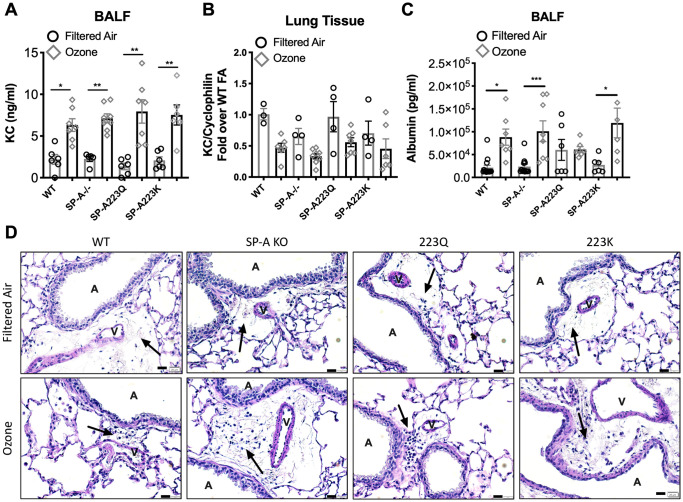
Genetic variation in SP-A2 on vascular permeability after exposure to ozone.(A) KC levels in BAL 24 hrs post ozone exposure. (B) KC gene expression in the lung tissue 24 hrs post ozone exposure. (C) Albumin protein levels in lavage fluid from O3 vs FA exposed mice. (D) Representative histology of lung sections depicting a vessel adjacent to an airway and surrounding lymphatic with cellular infiltration (arrows) of mice treated with FA (upper panel) or O3 (lower panel). Scale bar = 20 μm. V = vessel, A = airway. *p<0.05, **p<0.01, ***p<0.001.